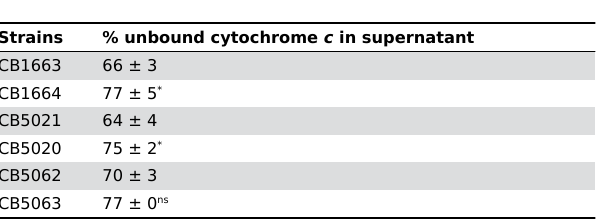
Table 3. Relative surface charge of DAP-S/DAP-R strain